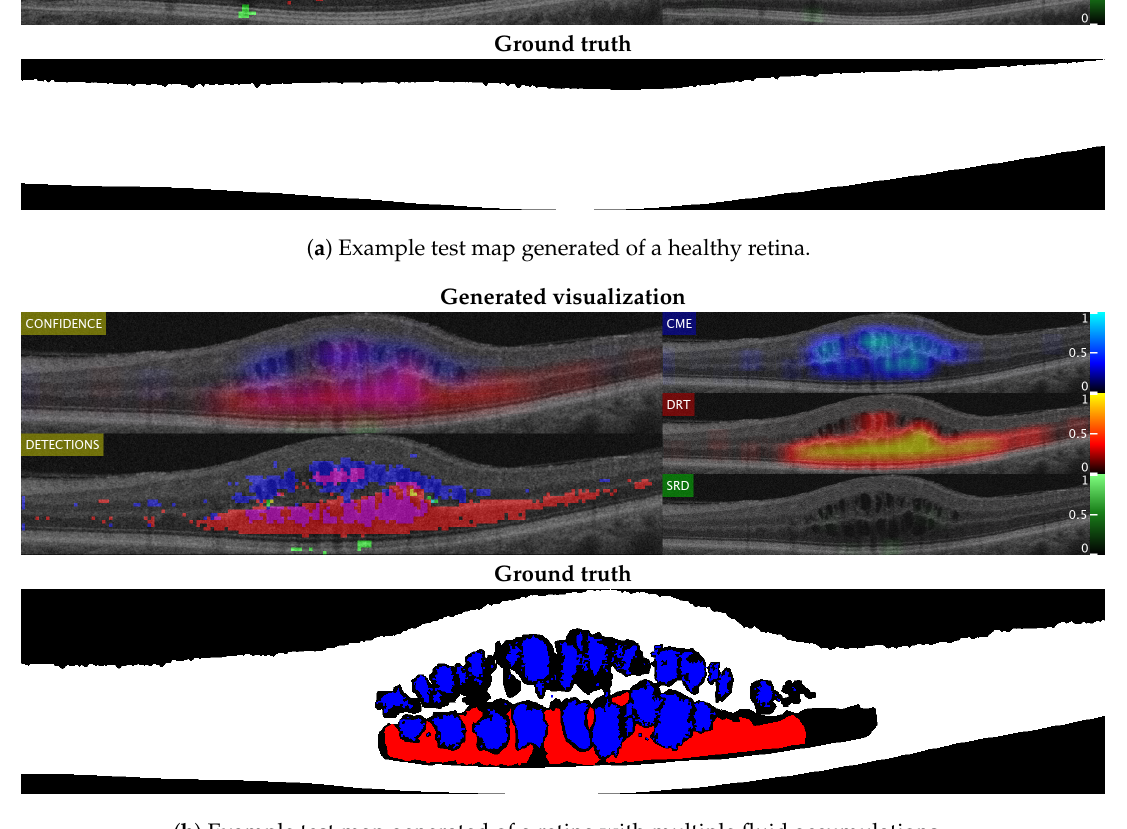
Figure 15. Test visualizations generated using images from the Cirrus